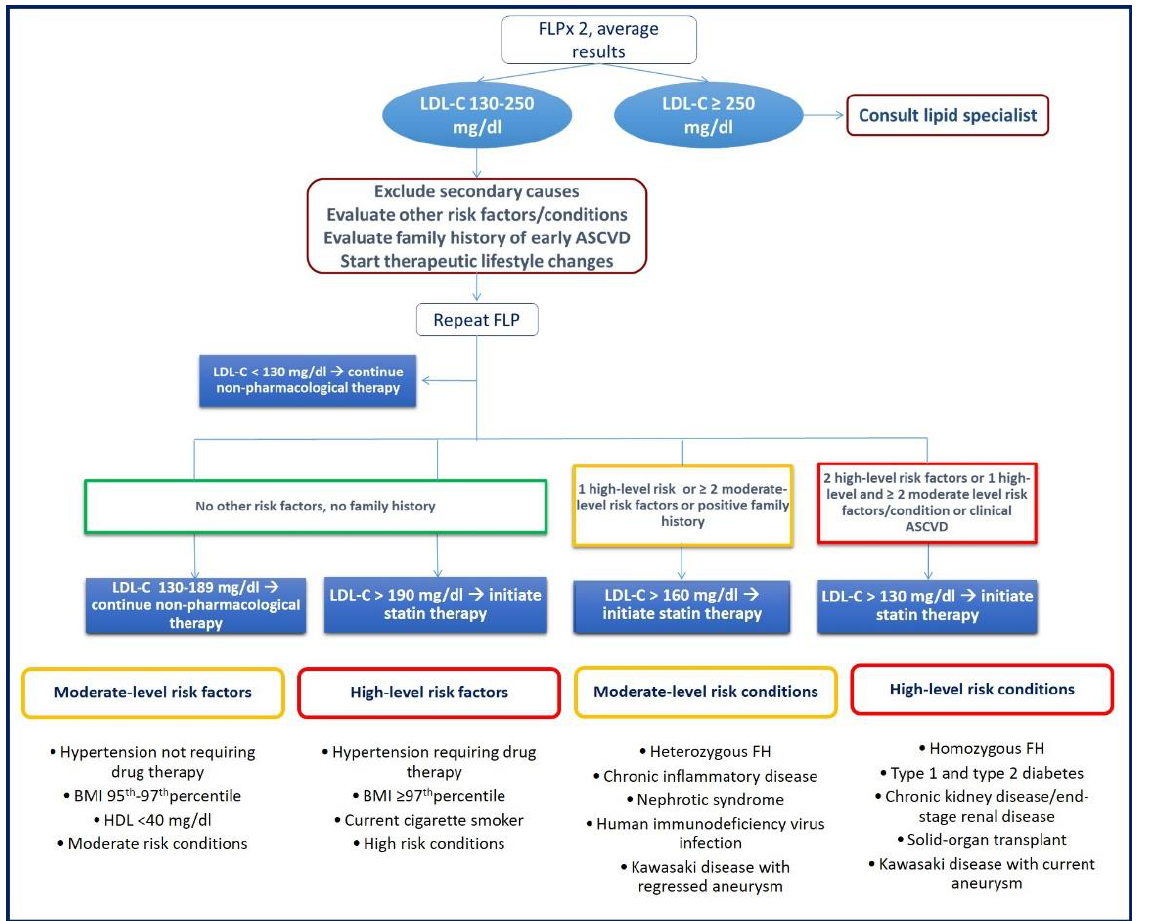
Figure 2. Recommendations for statin treatment in pediatric populations.